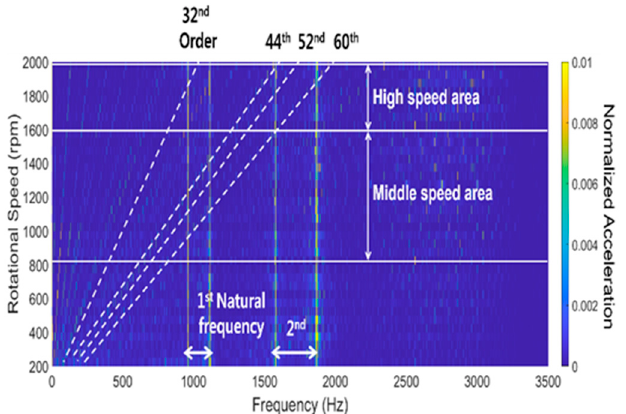
Figure 12. Waterfall graph of electromagnetic-structural vibration coupled analysis with 3-D entire FE model in the operating speed range.